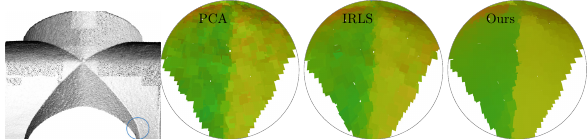
Figure 1. Comparison of normal estimation along a groin vault arris using PCA and IRLS and our method. Points are colored by their normal orientations.